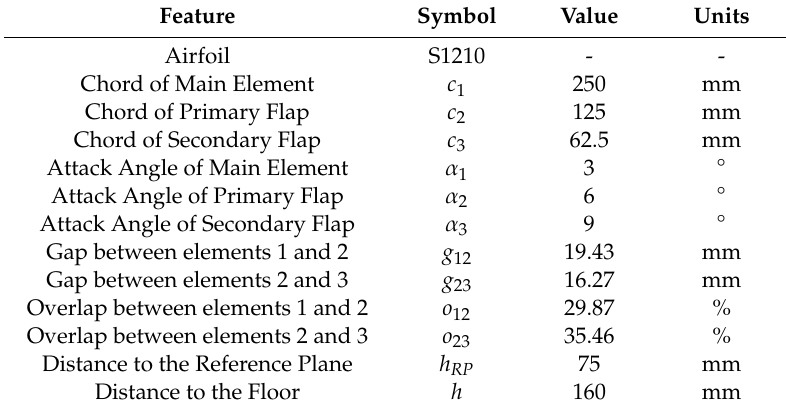
Figure 1. Baseline configurations: ( a ) one-element without endplates; ( b ) one-element with endplates; ( c ) three-element without endplates; ( d ) three-element with endplates. Table 2. Features of bidimensional three-element F1 front wing achieved by Gorostidi et al.